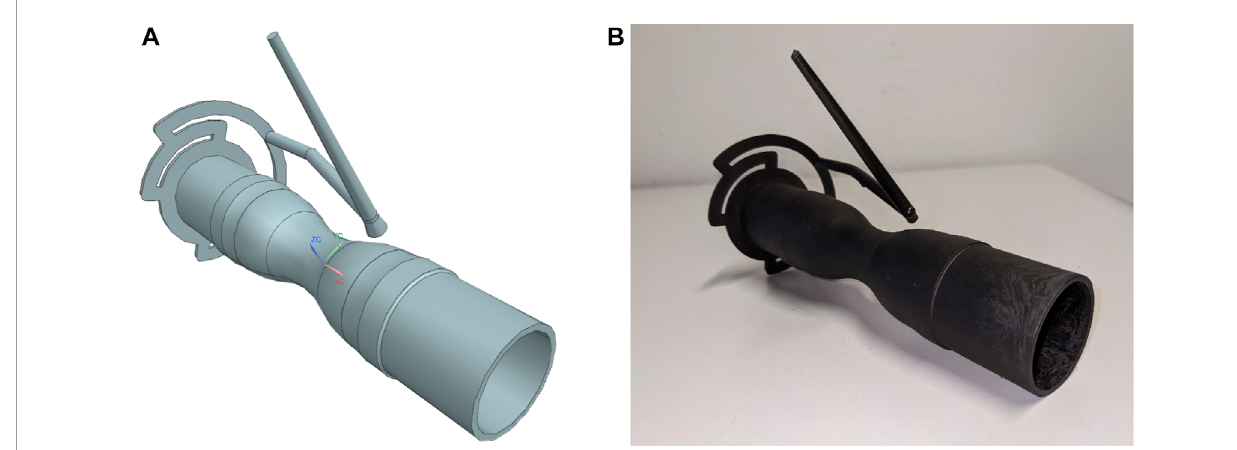
FIGURE 2 The Venturi tube with gate as CAD model (A) and after production (B) .